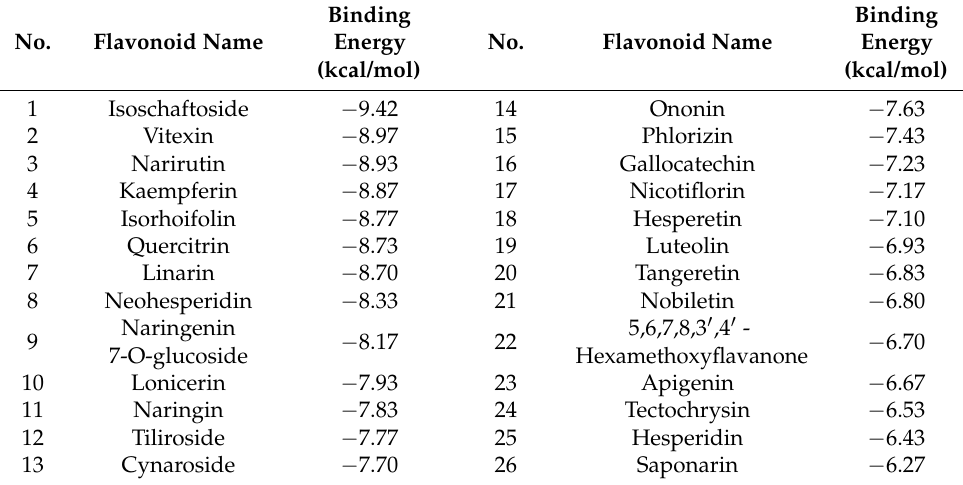
Table 4. Molecular docking results of flavonoids at RdRp.